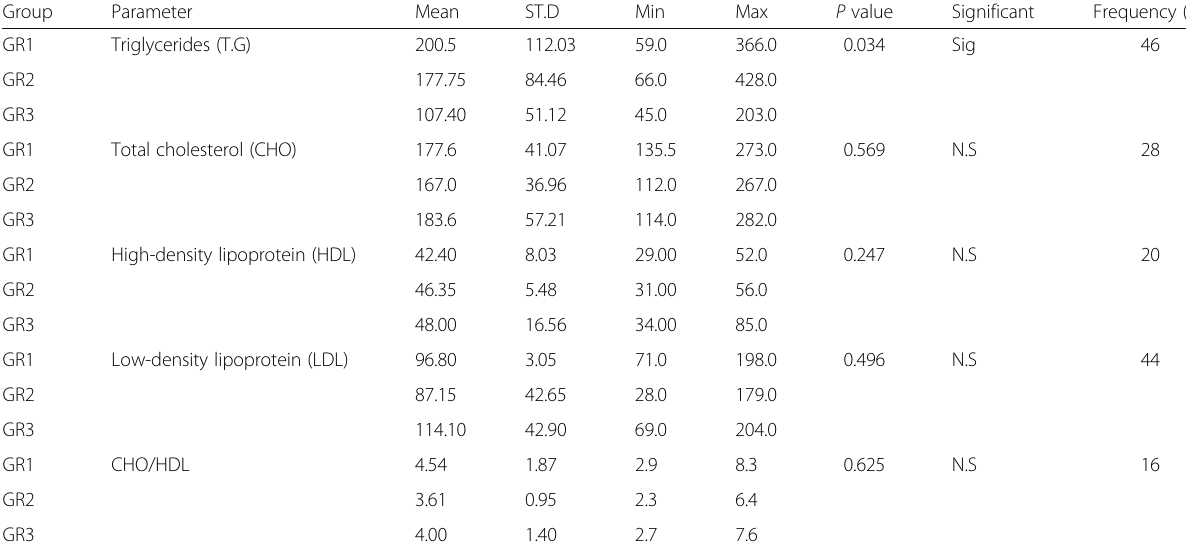
Table 5 Mean values and frequency of altered lipid profile Group Parameter Mean GR1 Triglycerides